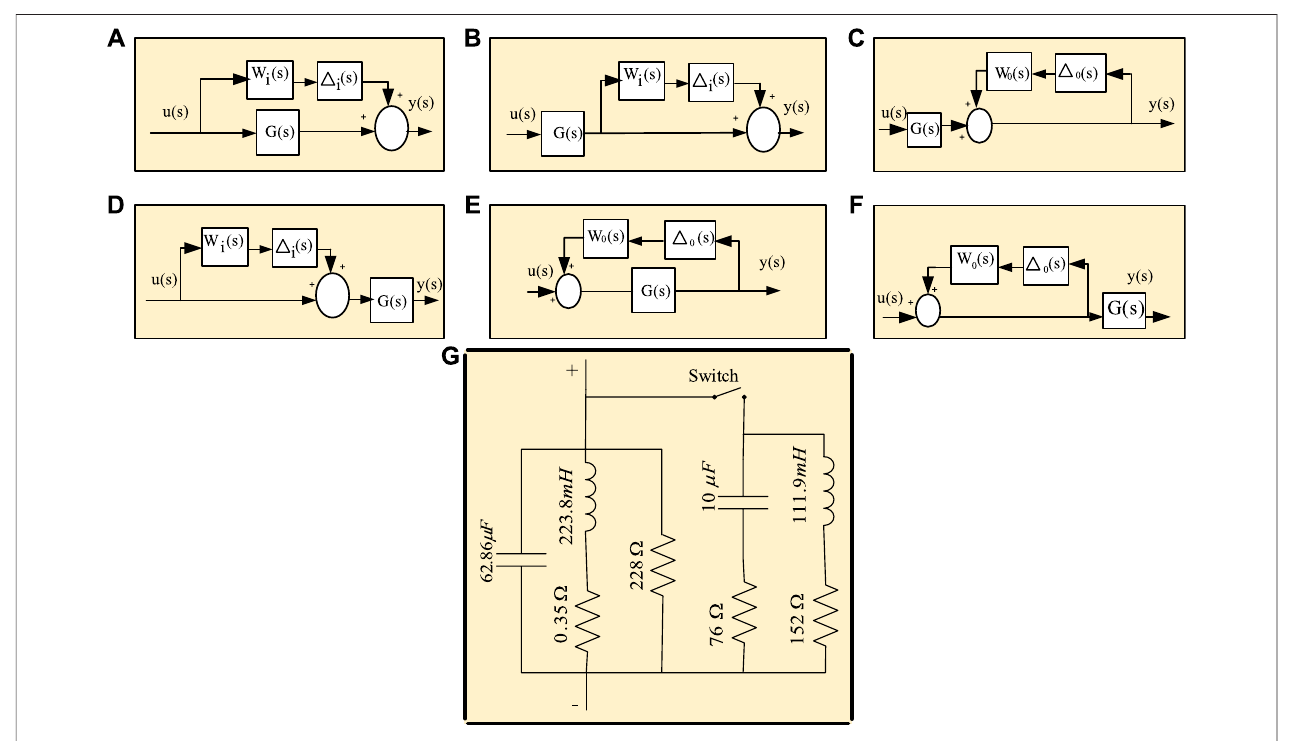
FIGURE 5 |(A) Additive uncertainty; (B) Additive output uncertainty; (C) Augmentative output inverse uncertainty, (D) Augmentative input uncertainty; (E) Additive inverse uncertainty, (F) Inverse augmentative input uncertainty; (G) Inclusion of unknown passive load to the SN